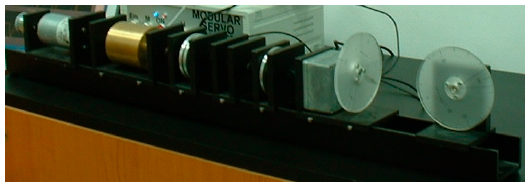
Figure 4. The MSS. Figure 4. The